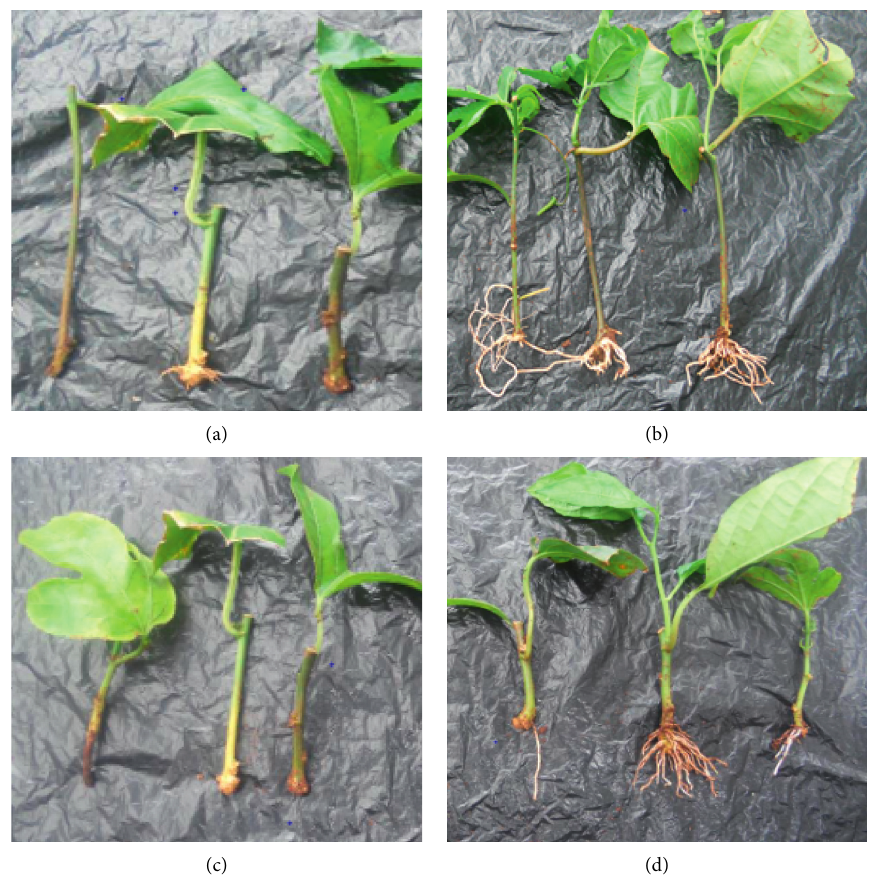
Figure 2: Root initiation from passion fruit stem nodal explants treated with different concentrations of putrescine: (a) purple-skinned passion fruit nodal explants not treated with putrescine; (b) purple-skinned passion fruit nodal explants treated with 2% putrescine treatment; (c) KPF 4 nodal stem explants not treated with putrescine; (d) KPF 4 nodal stem explants treated with 2% putrescine treatment.